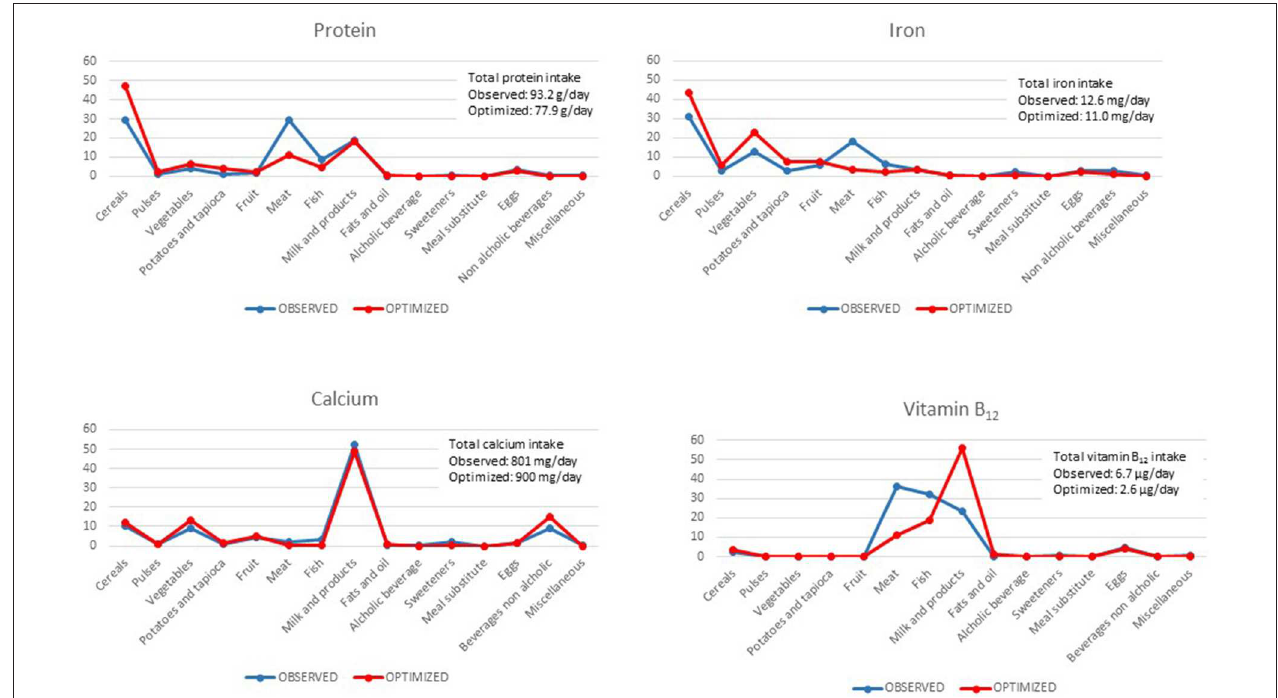
FIGURE 1 | Percentage contribution of food categories to total intake of selected nutrients (protein, iron, calcium, and vitamin B 12 ) in observed and optimized diet in the male adult population.